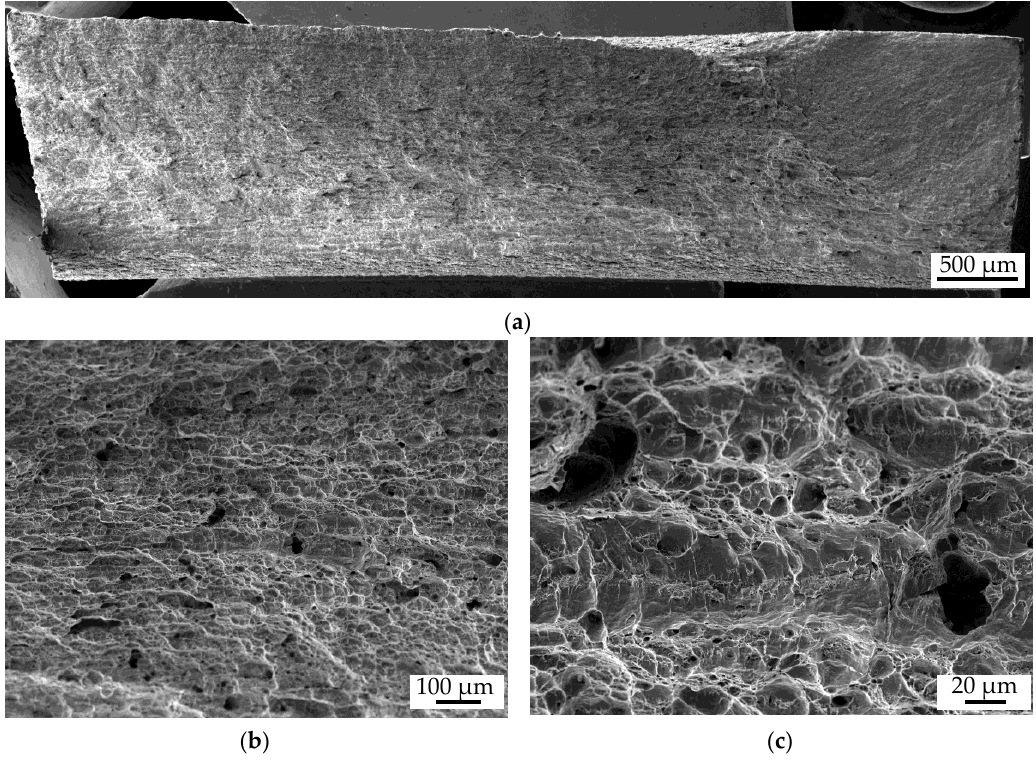
Figure 9. Fracture surface failed in constant amplitude test: σ min = 500 MPa, t = 110 mm, Δh = 5 mm; ( a ) overview; ( b , c ) close-ups of voids.